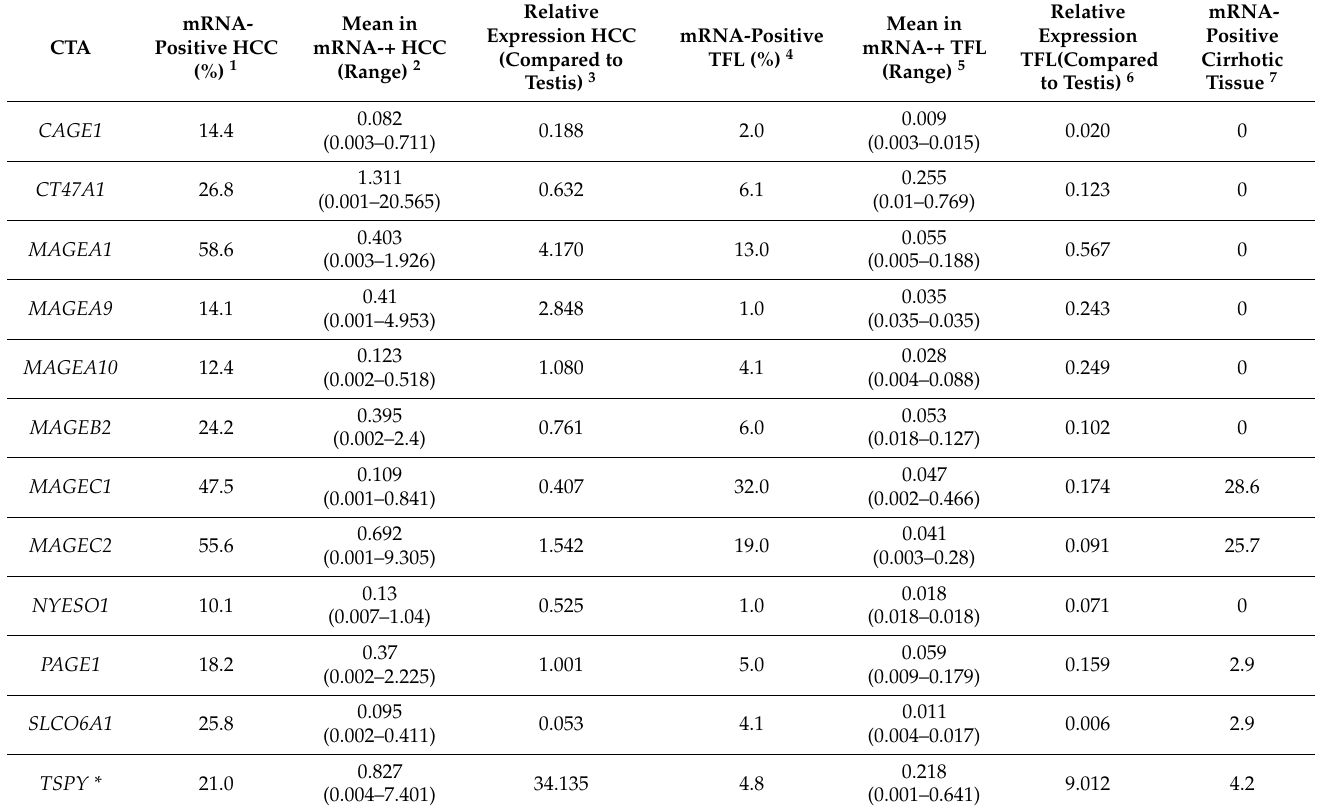
Table 1. mRNA expression of CTAs in tumor and TFL of HCC-patients. 1 Percentage of hepatocellular carcinomas (HCC) expressing mRNA of the CTA–meaning a Ct-value <35 and relative expression >0.001 ( n = 100); 2 Mean relative expression (relative to the geometric mean of the 3 household genes- GUSB, HPRT1, PMM1) level in HCCs expressing the CTA and range; 3 Mean relative expression of the CTA in HCC expressing the CTA, relative to the relative mean expression in 3 testis tissues; 4 Percentage of paired tumor-free liver (TFL) tissues expressing mRNA of the CTA ( n = 100); 5 Mean relative expression level in TFLs expressing the CTA and range; 6 Mean relative expression of the CTA in TFL expressing the CTA, relative to the relative mean expression in 3 testis tissues; 7 Percentage of non-cancerous/non-dysplastic cirrhotic liver tissues expressing the CTA ( n = 35); * % in